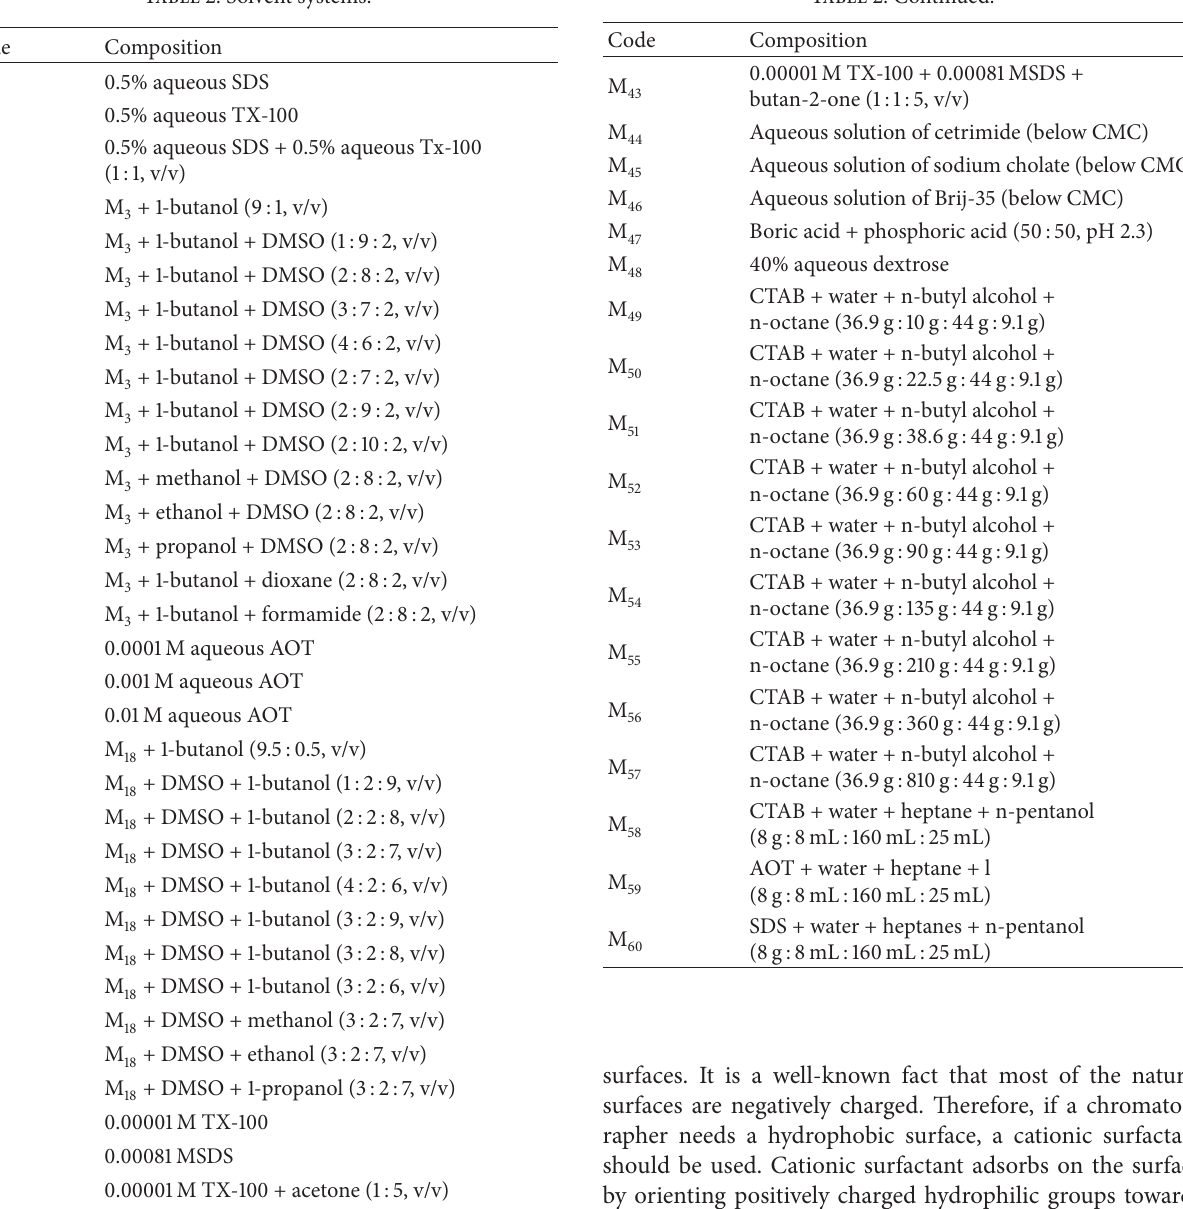
Table 2: Solvent